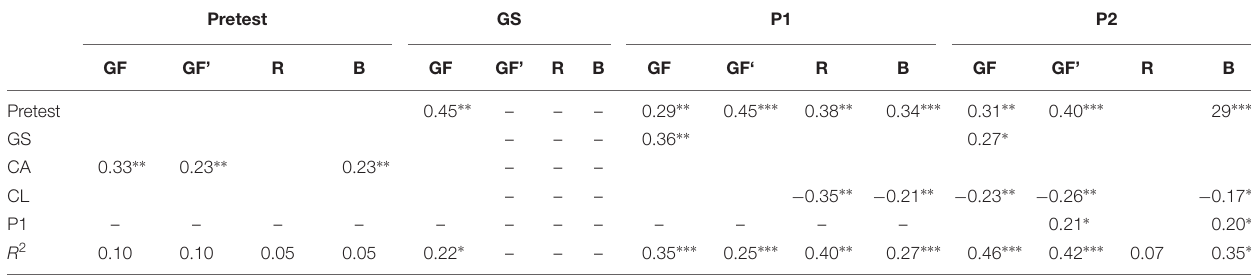
TABLE 3 | Empirical path models of significant influences of learners’ prerequisites on short-term and long-term retention.